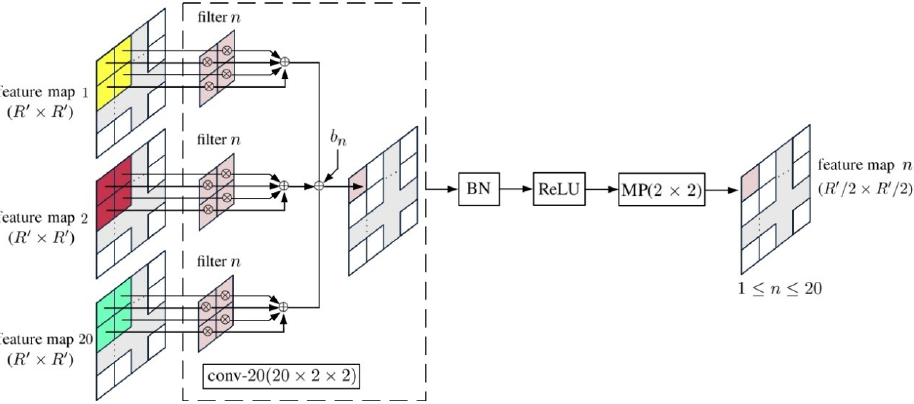
Figure 12. Schematic of convp-20 ( 20 × 2 × 2 ) .